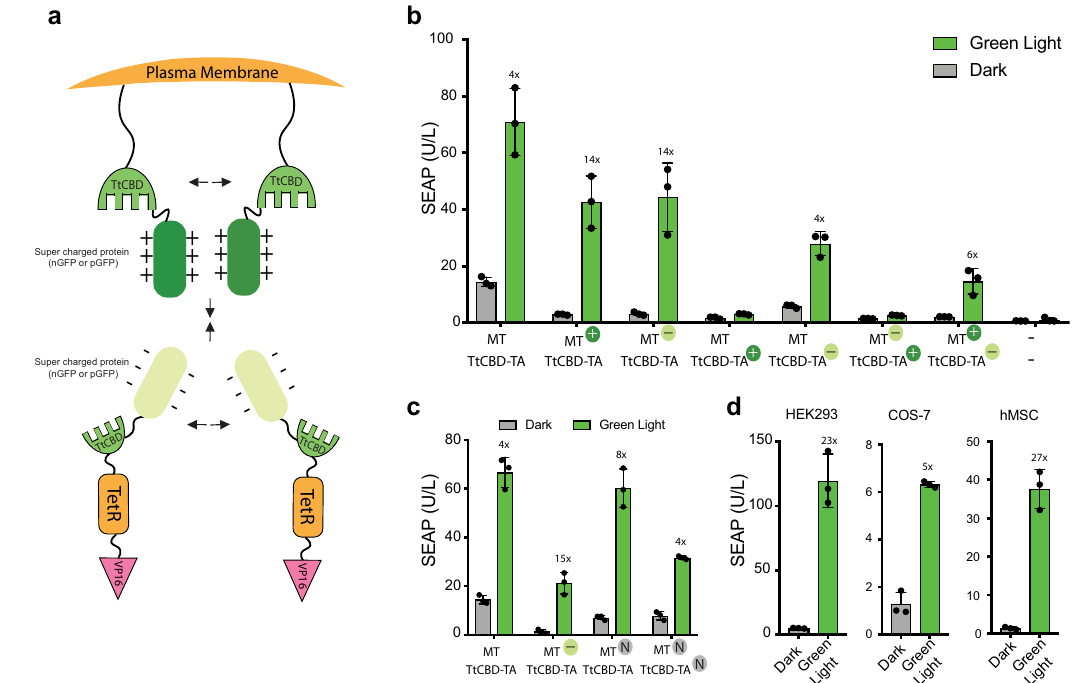
Fig. 2 Improvement of Glow Control speci fi city. a Schematic representation of supercharged GFP fusions to Glow Control components. Positively ( + , pMMZ283; P SV40 -Myr-TtCBD-pGFP-pA) or negatively ( − , pMMZ284; P SV40 -Myr-TtCBD-nGFP-pA) supercharged GFP was C-terminally fused to Myristoylation signal peptide-TtCBD (MT) and co-transfected in HEK293T cells with untagged (pMMZ272; P SV40 -TtCBD-TetR-VP16-pA) or N-terminally tagged with positive ( + , pMMZ290; P SV40 -pGFP-TtCBD-TetR-VP16-pA) or negative ( − , pMMZ291; P SV40 -nGFP-TtCBD-TetR-VP16-pA) supercharged GFP fused to the TtCBD-transactivator (TA) alongside a SEAP reporter construct (pT1017; P TetO7- P CMVmin -SEAP-pA). b Quanti fi cation of produced SEAP in the supernatant of HEK293T cells co-transfected with different variants (untagged, nGFP, or pGFP) of Myr-TtCBD (MT) and TtCBD-transactivator (TA). c Comparison of the ef fi ciency of the optimized supercharged Glow Control with either untagged effectors or effectors tagged with native GFP (N, pMMZ351; P SV40 -Myr-TtCBD-GFP-pA, pMMZ309; P SV40 -GFP-TtCBD-TetR-VP16-pA) in a side-by-side experiment. d Validation of Glow Control- mediated SEAP expression in different mammalian cell lines. Cells were co-transfected with pMMZ284 (P SV40 -Myr-TtCBD-nGFP-pA), pMMZ272 (P SV40 - TtCBD-TetR-VP16-pA), and pT1017 (P TetO7- P CMVmin -SEAP-pA). For plots b – d , HEK293T cells ( b , c ) or indicated cells ( d ) were stimulated with pulsed green light (545 nm; 15 s ON/45 s OFF, and 88 μ W/cm 2 ) for 12 h/day and SEAP expression was measured at 48 h after the start of illumination. Control cells were incubated in the dark. Values are mean ± SD ( n = 3) and numbers above the bars indicate fold changes of reporter (SEAP) expression vs. the corresponding dark group. Source data are provided as a Source Data fi